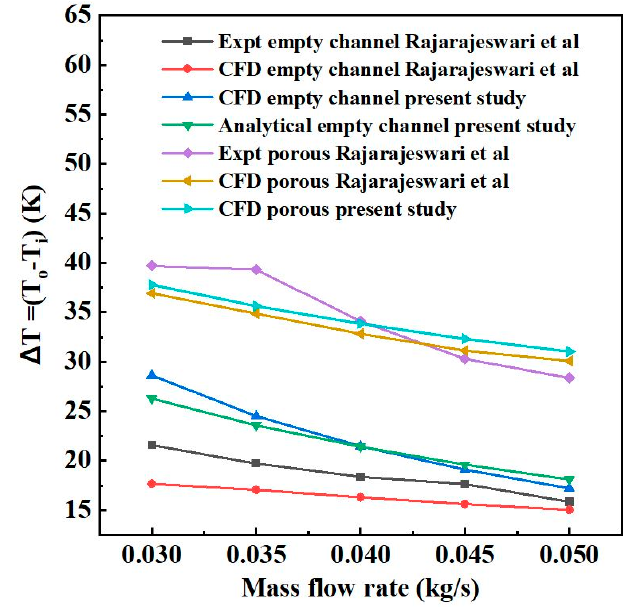
Figure 5. Validation of analytical and CFD results of present empty channel SAH with Rajarajeswari et al. [13].